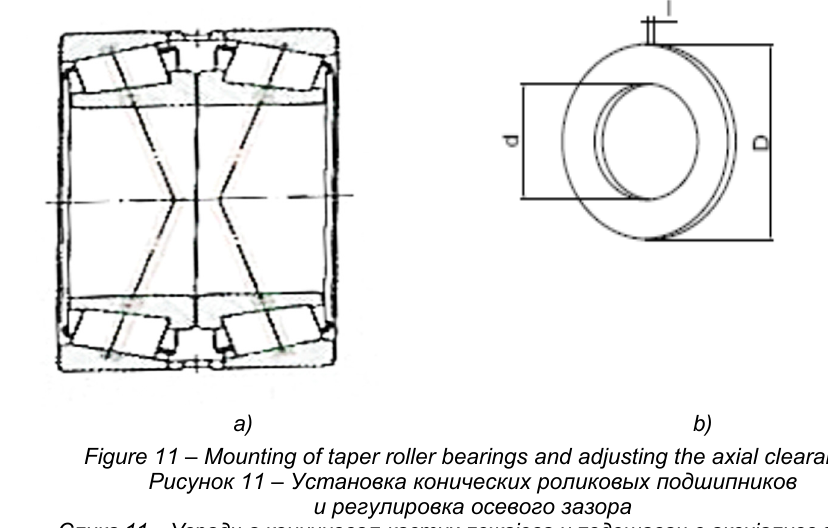
Figure 11 – Mounting of taper roller bearings and adjusting the axial clearance Рисунок 11 – Установка конических роликовых подшипников и регулировка осевого зазора Слика 11 – Уградња коничноваљкастих лежајева и подешавање аксијалног